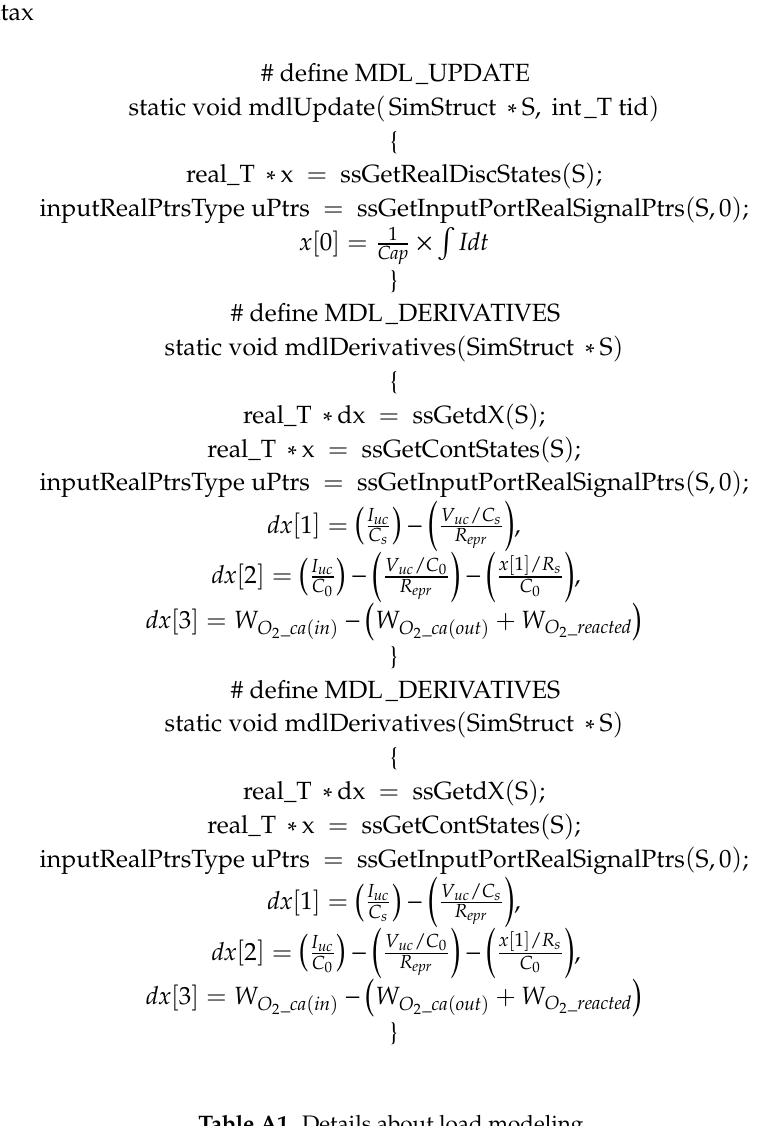
Table A1. Details about load